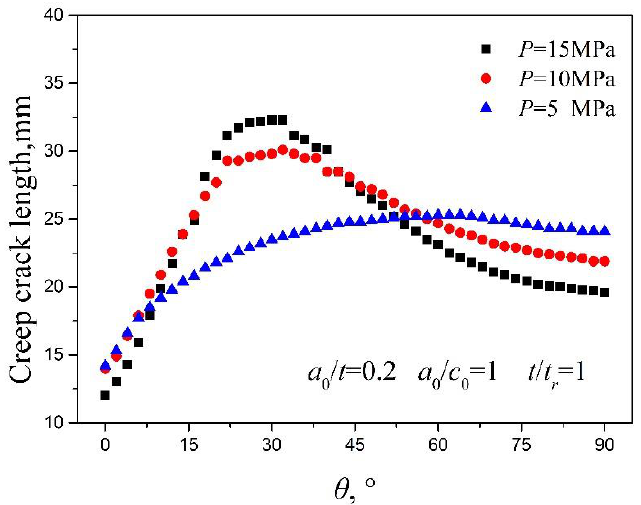
Figure 14. The relationship between the creep crack propagation length and θ .